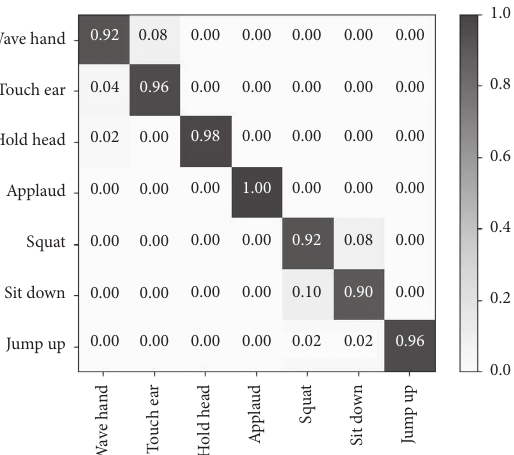
Figure 4: The confusion matrix of action interaction with the Pepper robot.